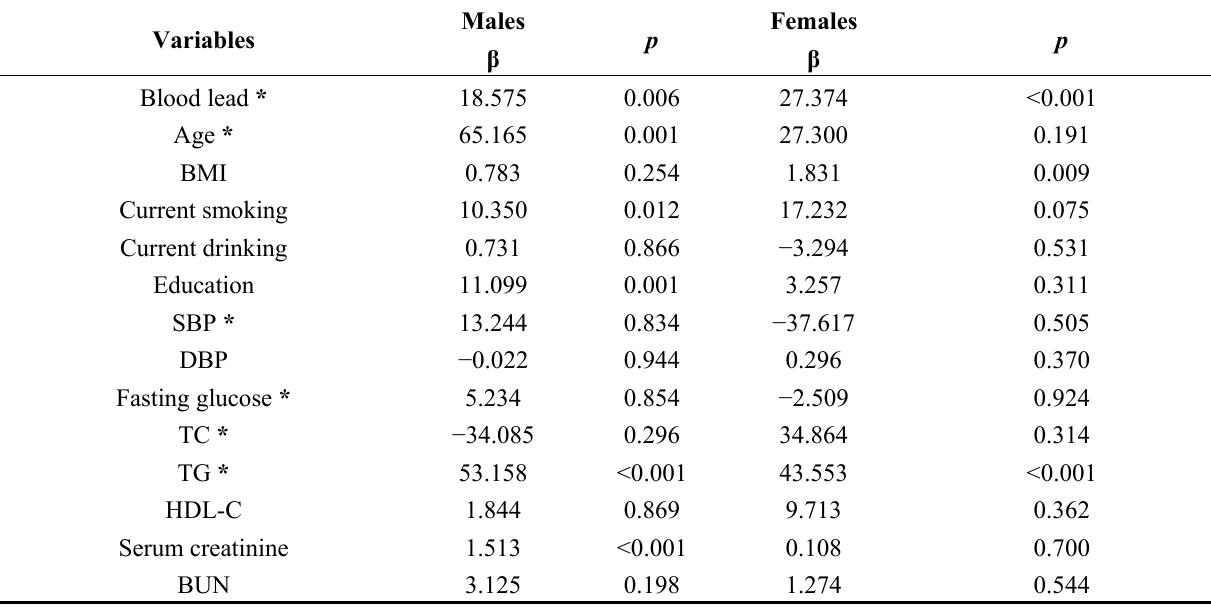
Table 3. Multiple linear regression analysis of the effects of independent variables on serum uric